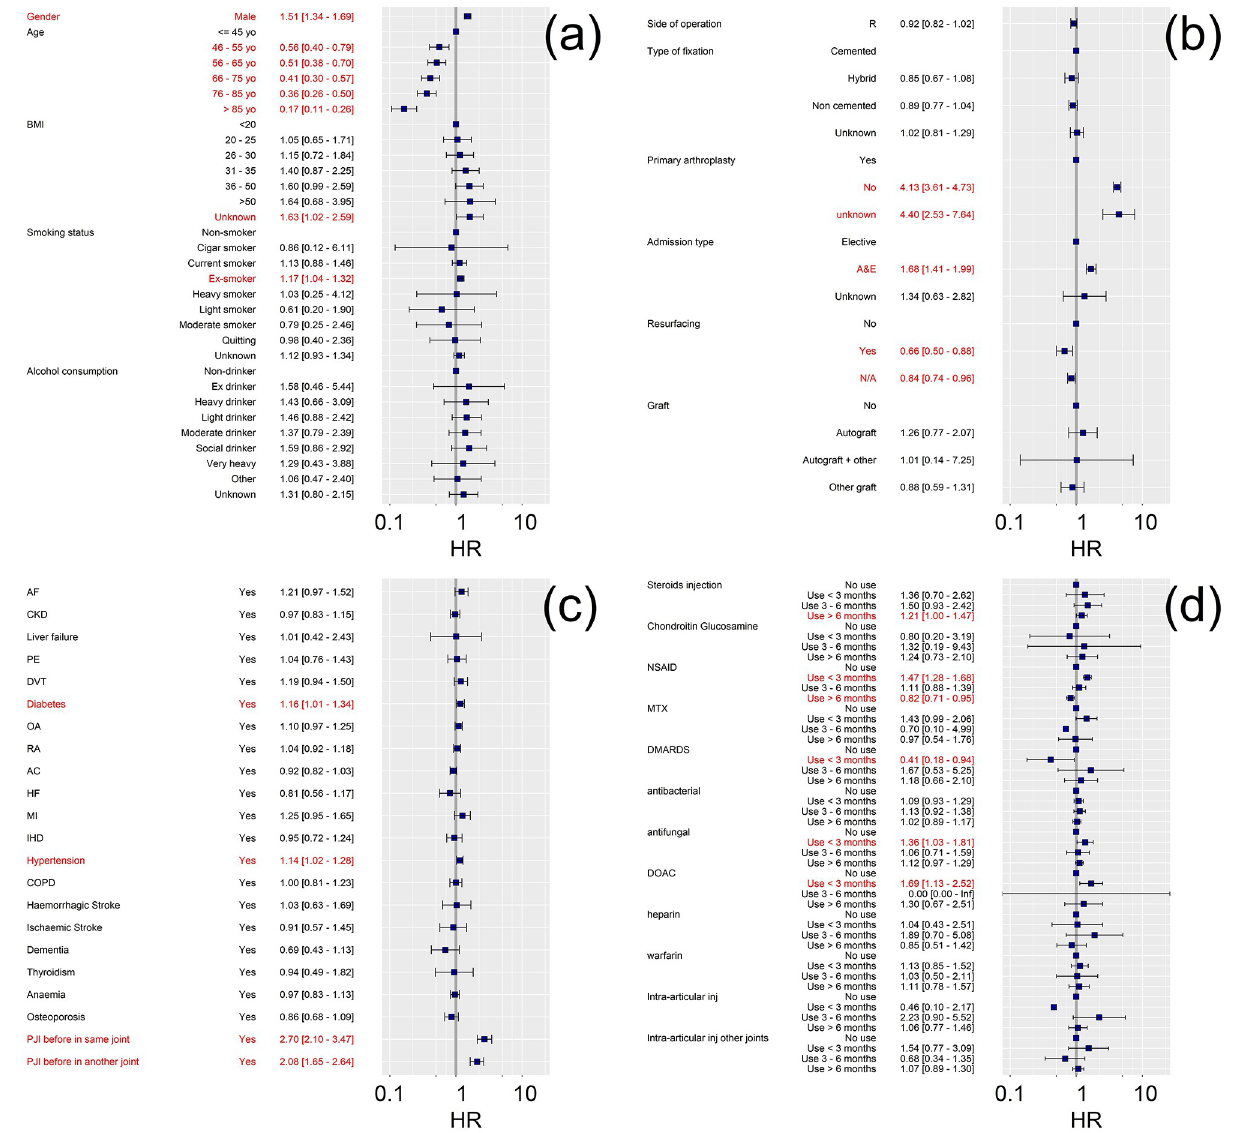
Fig 2. Forest plot of Hazard ratios (HR) of multivariate Cox proportional regression model for variables related to patient characteristics (a), arthroplasty surgery (b), medical history (c) and drug history